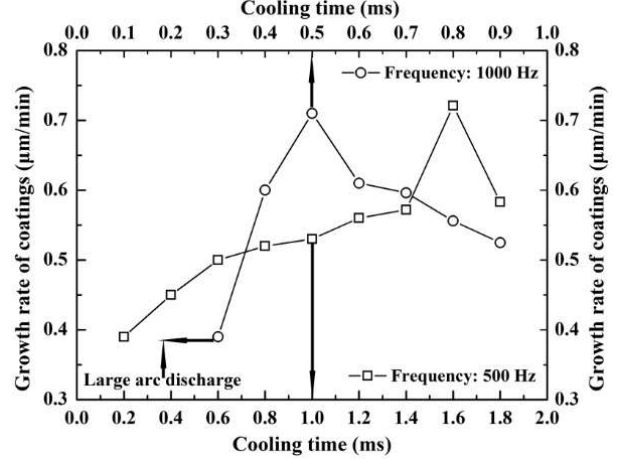
Figure 8. The growth rate of coatings at the frequency is 500 Hz and 1000 Hz, the duty cycle is from 10% to 90%.